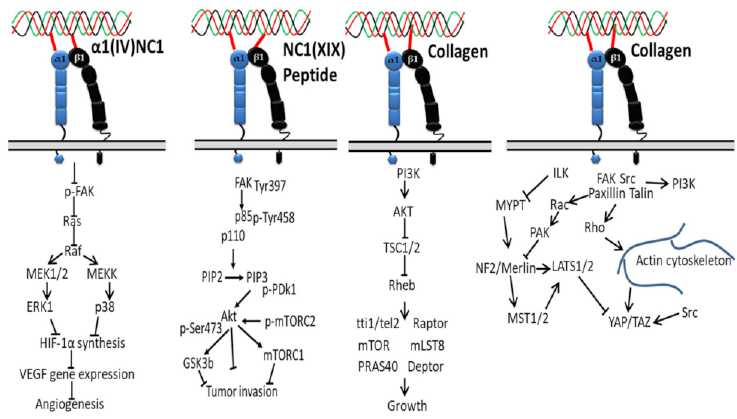
Figure 3. Collagen integrin signals in